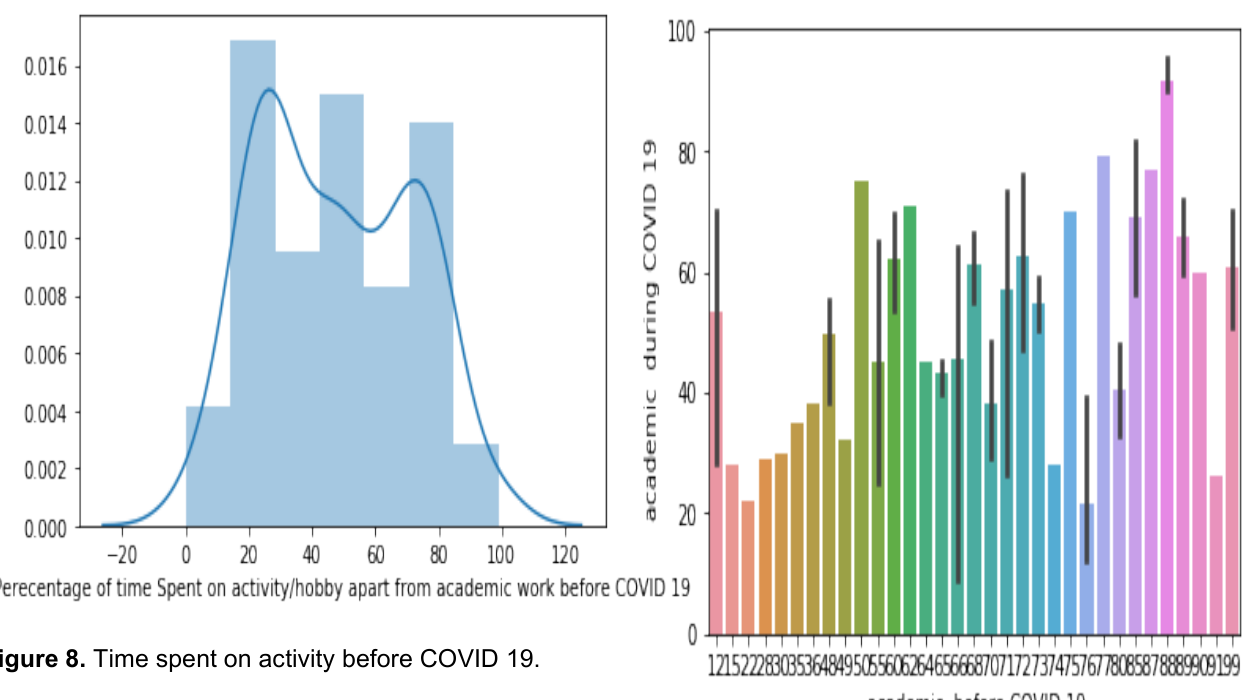
Figure 8. Time spent on activity before COVID 19.